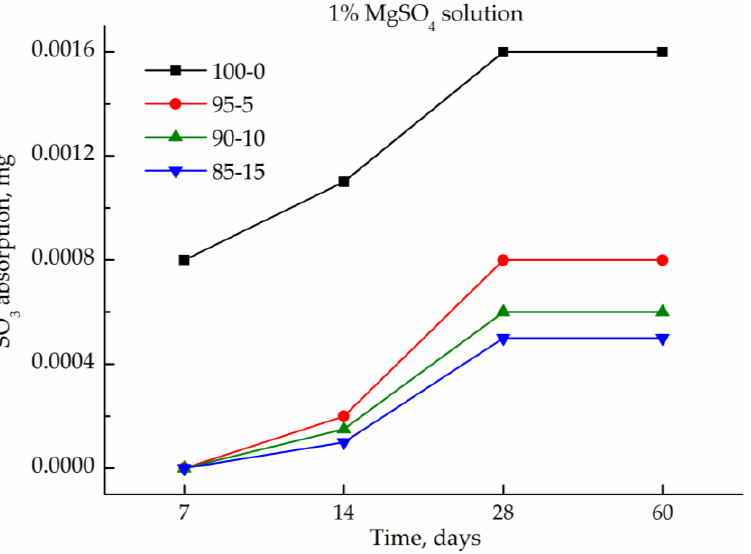
Figure 13. Kinetics of the sulphate ions absorption by the mixed cement samples from 1% MgSO 4 solution.